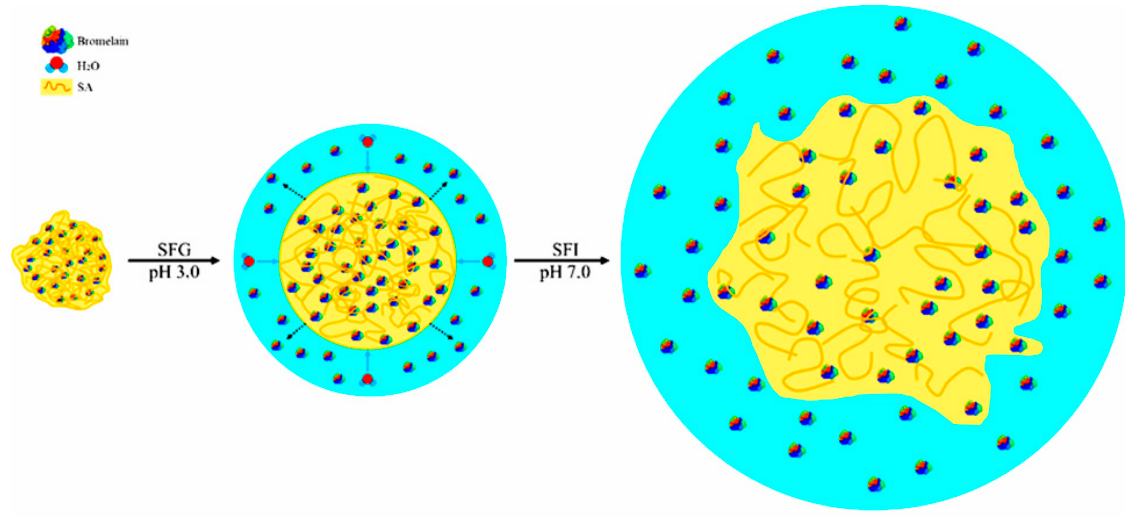
Figure 3. Dry system ( left ); process of rehydration and protein diffusion in contact with SFG in pH 3.0 ( center ) and processes of degradation of the systems with release of non-diffuse proteins from the gastric phase in pH 7.0 ( right ).